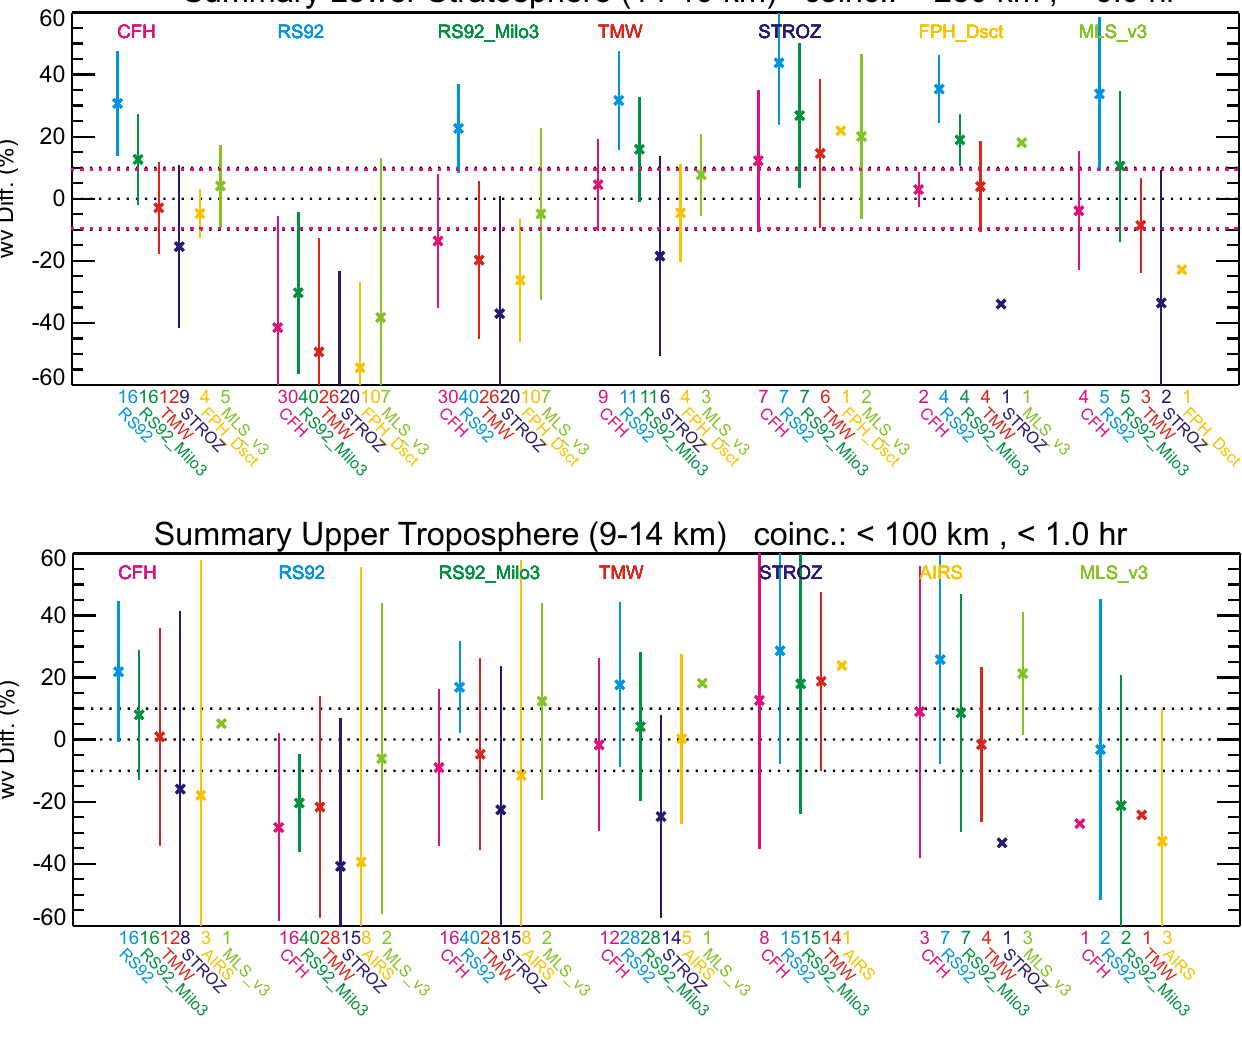
datasets available in the lower (bottom panel) and mid- (top panel) troposphere. The symbols indicate the percent differ- ence between the instrument listed in the upper part of each panel and those listed in the bottom part (where the number of coincidences is listed). The colors can be used to eas- ily identify each instrument. The vertical bars indicate the